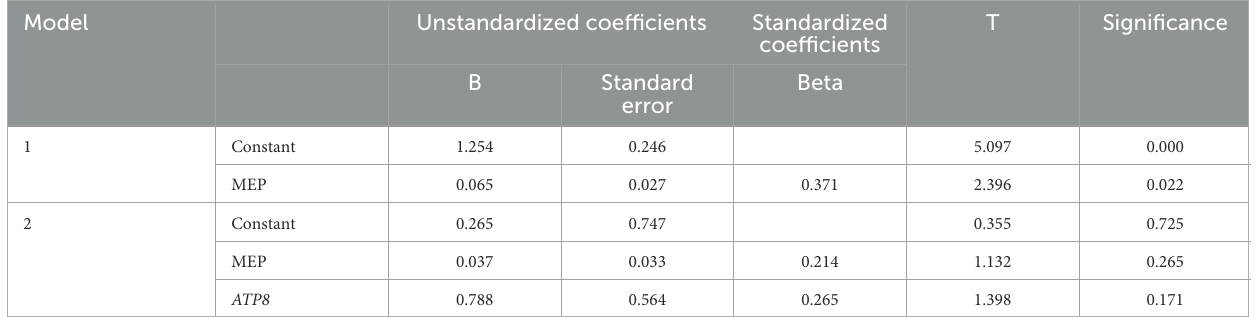
TABLE 6 The mediation effects of MT-ATP8 methylation on the association of MEP levels with triglycerides.